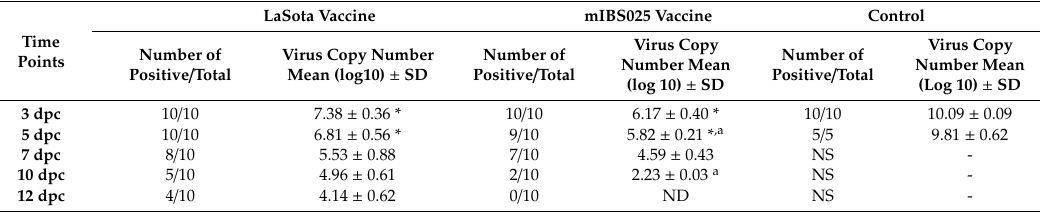
Table 5. Cloacal virus shedding among vaccinated and non-vaccinated birds at di ff erent time points post challenge.